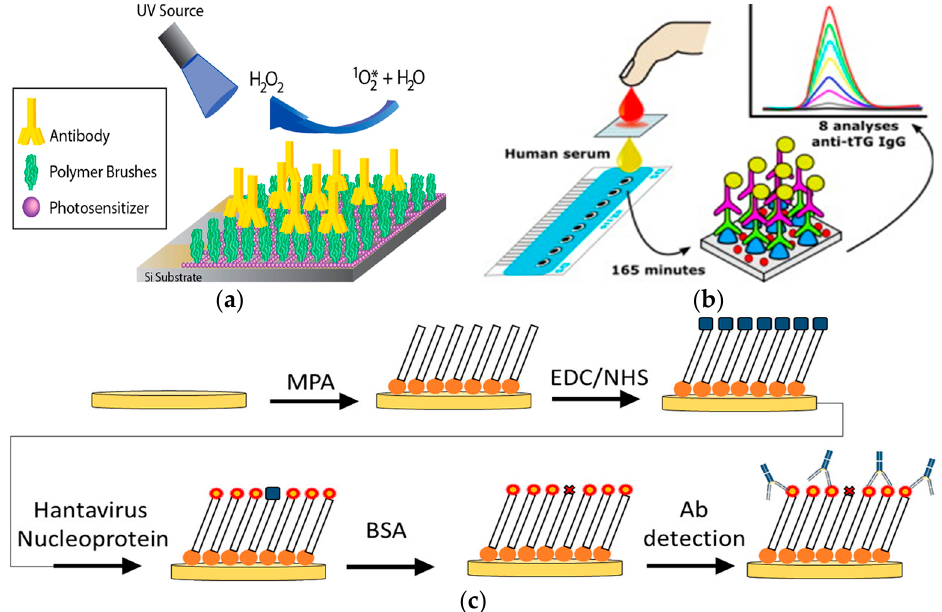
Figure 3. ( a ) Schematic of antibody-catalyzed water oxidation pathway-based electrode. (Adapted with the permission from Ref. [33]. Copyright © 2014 American Chemical Society.) ( b ) Schematic of the biosensor for detection of the antibody-bound quantum dots. (Adapted from Ref. [38]. Copyright © 2014 Elsevier B.V.) ( c ) Illustration of the fabrication process of self-assembled monolayer with immobilized hantavirus nucleoprotein for detection of the antibody (Adapted from Ref. [44].